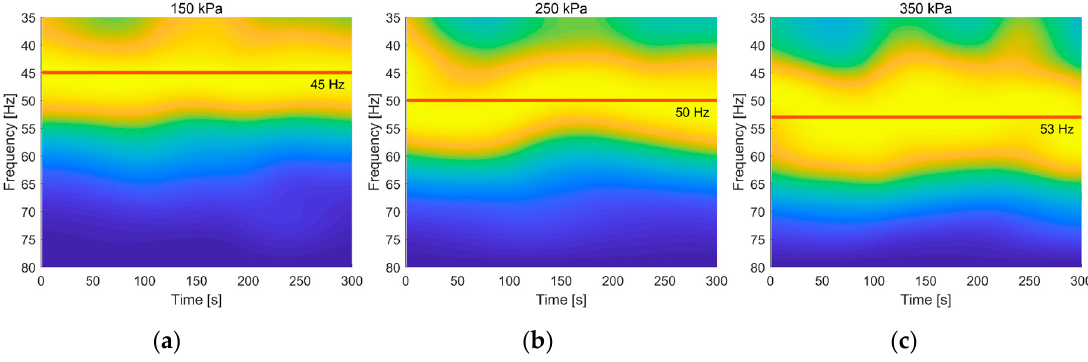
Figure 8. Segmented amplitude-frequency curve of accelerometer A (rim well) in circumferential direction: ( a ) 150 kPa; ( b ) 250 kPa; ( c ) 350 kPa.